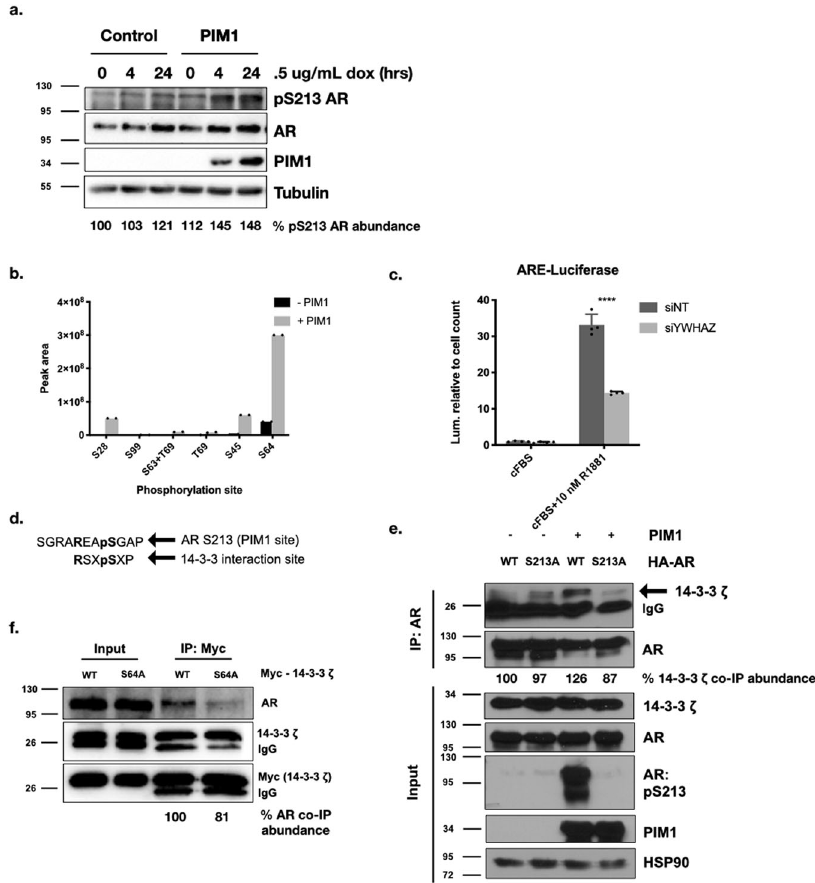
Fig. 1 PIM1 phosphorylates the AR and 14-3-3 ζ and coordinates their interaction. a Inducible PIM1 over-expression in LNCaP cells results in an increase in phosphorylation of AR at S213 (including relative abundance of pS213 AR quanti fi ed). b 14-3-3 ζ functions as an AR co-activator in LNCaP cells. 14-3-3 ζ knockdown in ARR3-luciferase assay leads to reduction in AR transcriptional activity (33.10 + / − 3.008 vs. 14.39 + / − 0.396, p = .000017, n = 4 biological replicates, two sided t test). c PIM1 phosphorylates 14-3-3 ζ in vitro, predominately at S64. d The PIM1 phosphorylation site on AR, S213, lines up with the 14-3- 3 consensus interaction site. e 14-3-3 ζ co-immunoprecipitates with AR, particularly in the presence of PIM1 over-expression, and less so with AR phosphorylation mutant S213A (including relative abundance of AR co-IP quanti fi ed). f AR co-immunoprecipitates with WT 14-3-3 ζ in LNCaP cells, and less so with 14-3-3 ζ phosphorylation mutant S64A (including relative abundance of 14-3-3 ζ co-IP quanti fi ed). Error bars refer to standard